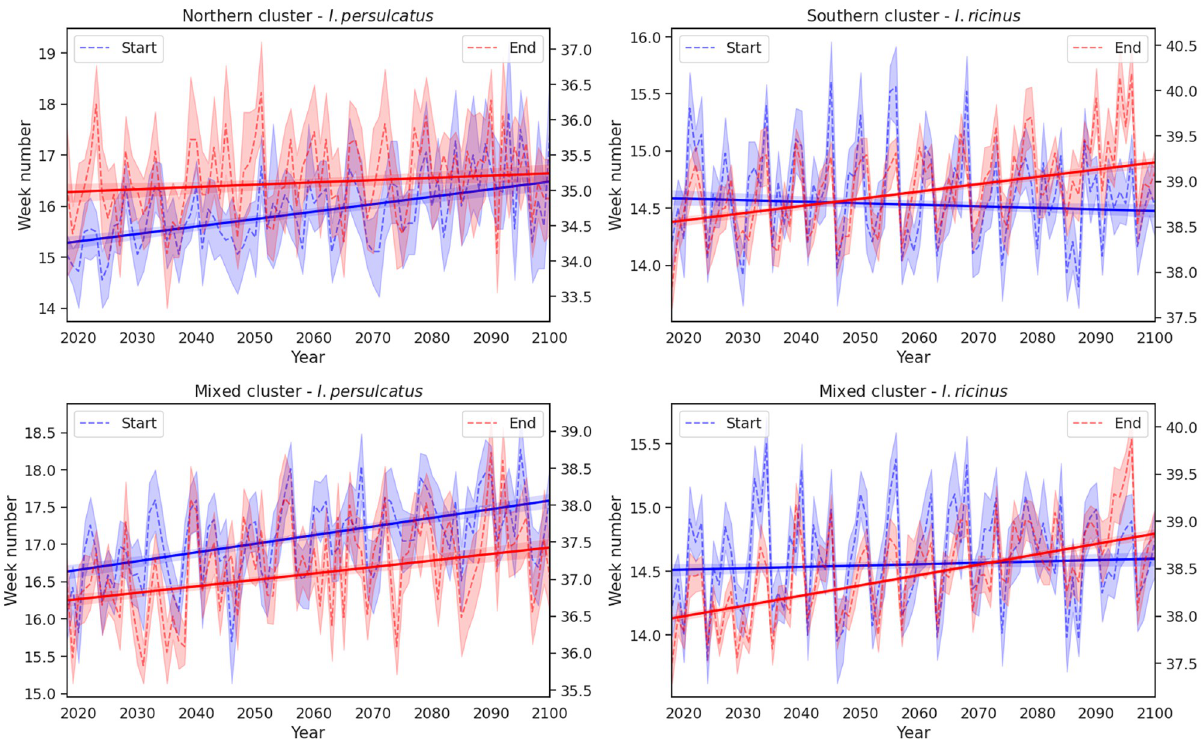
Fig 8. The start (blue) and end (red) of tick season projected by the LSTM models until the end of the century for the three federal region clusters investigated. The Southern cluster, where I. ricinus is located, is shown on the top right panel, the Northern cluster, where I. persulcatus is found, on the top left panel, and the mixed cluster, where both species of ticks are found, on the bottom row of panels. The dashed lines show the LSTM models’ projection in terms of week number and the solid lines a linear regression model fit to the time-series to visualise the trend.